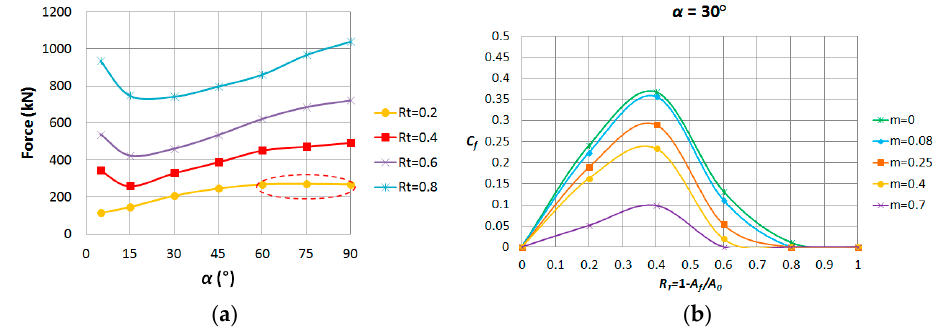
Figure 10. ( a ) Extrusion force at different cross-section reductions for m = 0.08 and dead zone effect; ( b ) Central damage ( C f ) versus cross-section reduction for α = 30° and different friction factors. ( b ) Central damage ( C f ) versus cross-section reduction for α = 30 ◦ and different friction